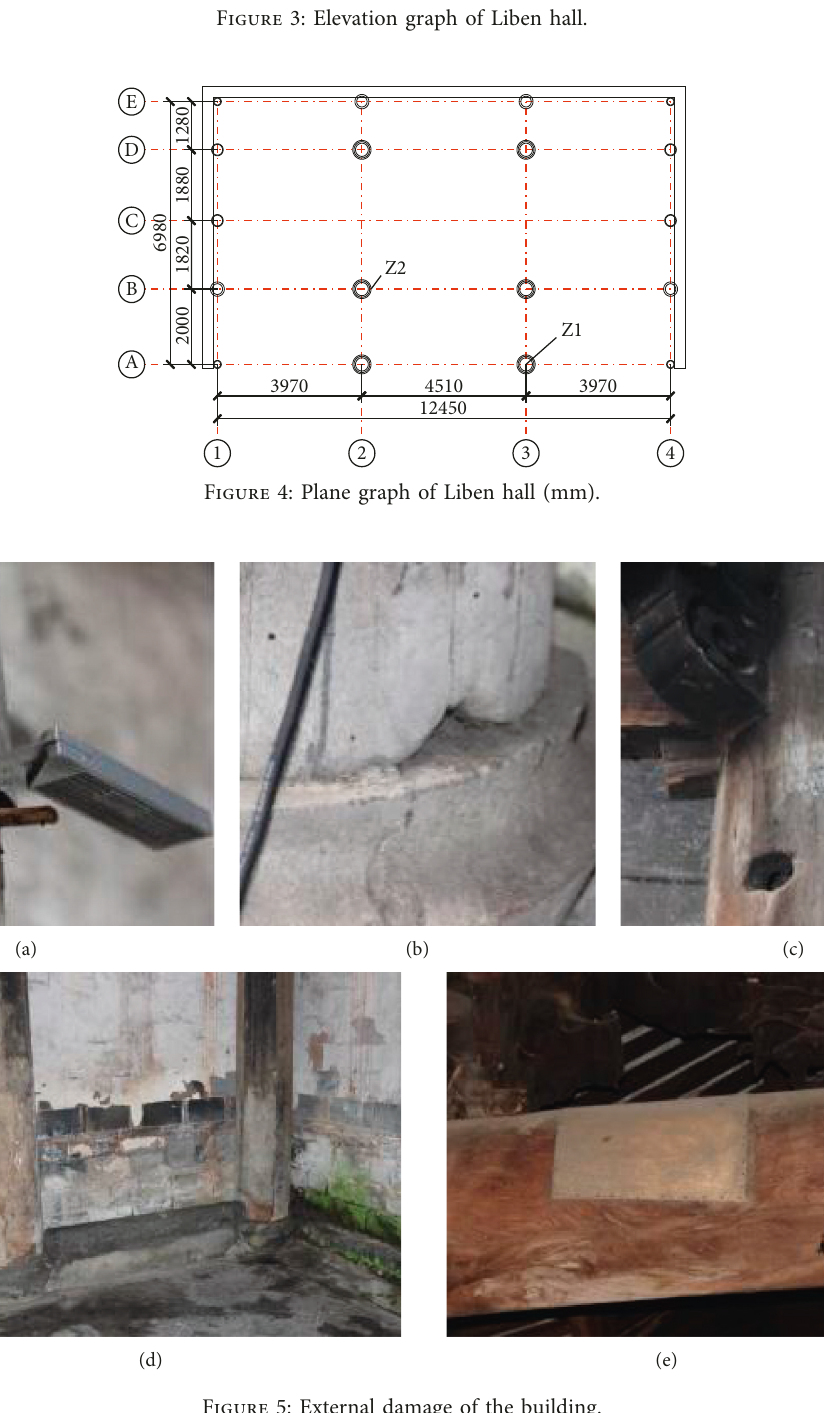
Figure 5: External damage of the